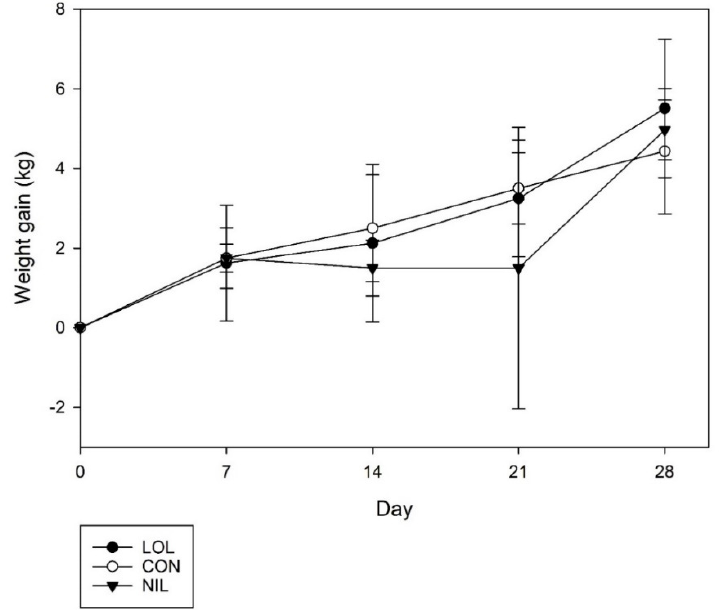
Figure 4. Average weight gain of lambs with mixed parasite infection treated with a meadow fescue seed extract with (LOL) or without loline (NIL), or non-treated (CON). Growth efficiency measured as gain per feed (kg LWG/kg DM intake) varied throughout the trial ( p = 0.01, Figure 5). Overall, average growth efficiency was 0.18 in CON lambs, which was less ( p = 0.01) than in LOL- (0.24) or NIL- (0.23)-treated lambs. Overall, day by treatment interaction was significant ( p = 0.01), with differences detected between days 8–14 and 15–21, where NIL was less than CON or LOL. Between days 22 and 28, treatments varied, with CON greater than LOL or NIL.